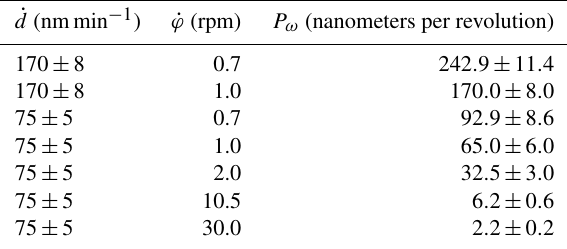
Table 1. The deposition rate ˙ d used, substrate rotation speed ˙ ϕ and resulting growth pitch P ω for the deposition of the tantalum sam-